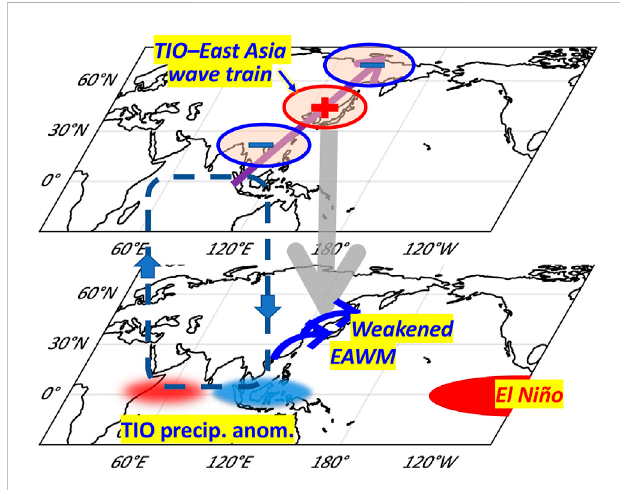
Schematic diagram illustrating possible roles of the precipitation anomalies in the tropical Indian Ocean (TIO) in the teleconnection of ENSO over East Asia. During El Niño early winter, positive and negative precipitation anomalies occur in the western and eastern TIO, respectively. The diabatic heating associated with the precipitation anomalies, particularly the eastern part, stimulates a Rossby wave train emitting from the TIO towards East Asia. This TIO-East Asia wave train further leads to a weakened East Asian trough, and thereby a weakened EAWM. The situations are reversed in La